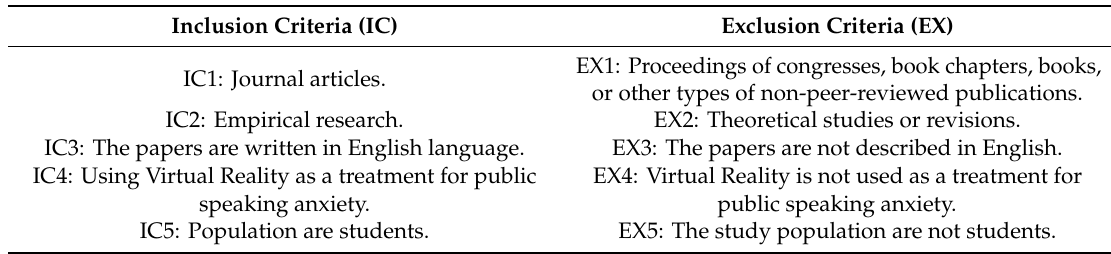
Table 1. Inclusion and exclusion